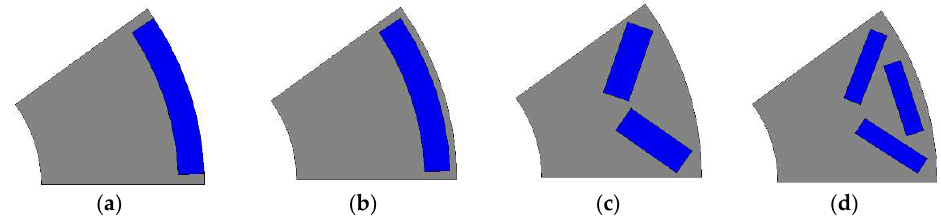
Figure 10. Rotor topologies: ( a ) Topology 2, ( b ) Topology 3, ( c ) Topology 4, and ( d ) Topology 5.